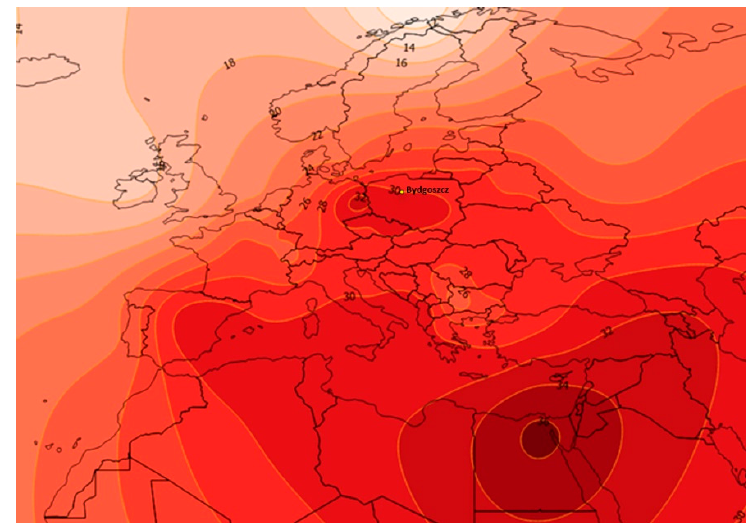
Figure 1. Spatial distribution of the average daily maximum temperature in Europe on the analyzed hot days of June 2019 [16] (https://www.ogimet.com/gsynres.phtml.en, accessed on 14 April 2020).